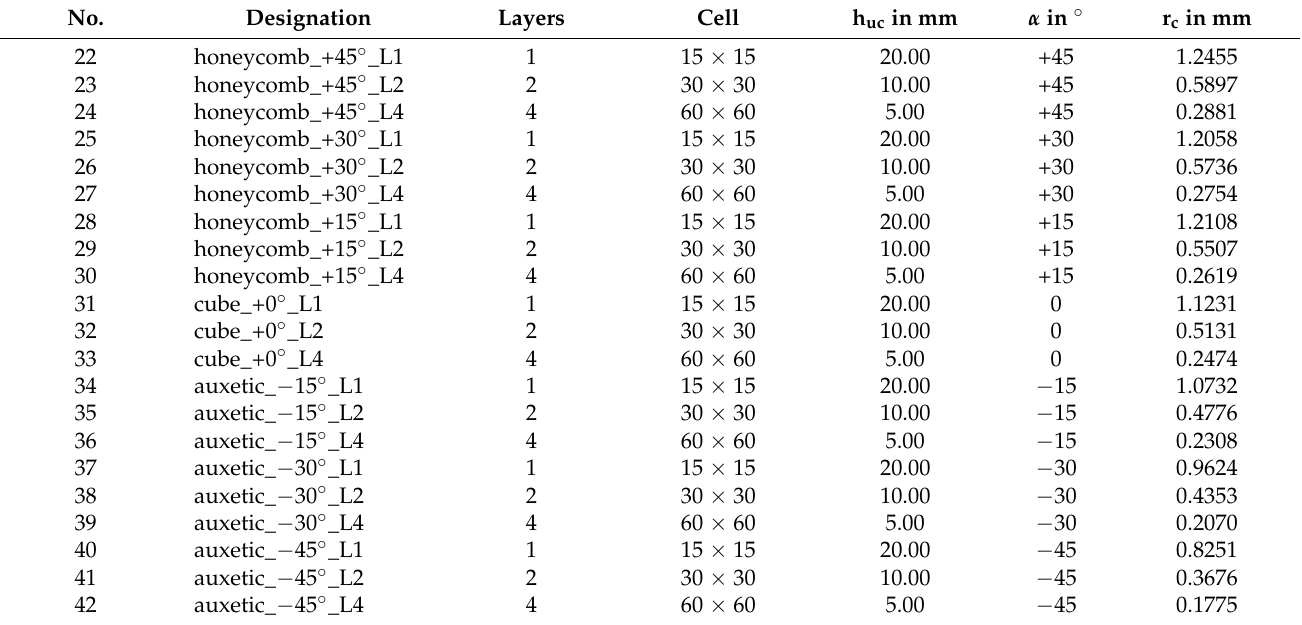
Table 4. Topology and parameters: auxetic and non-auxetic 3D lattice cores. See Figure 8.